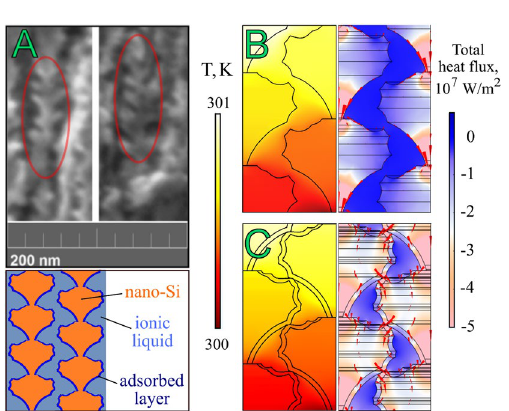
Figure 5. SEM cross-sectional images of PSi (highlighted areas show tentative markers indicating the features of the morphology of the porous structure of silicon) and below a schematic view of averaged by size Si nanocrystalline with a structured IL layer around it as the basis for modelling ( A ); schematic view of temperature distribution on the left half and cross-plane total heat flux q on the right half in PSi ( B ) and "PSi/IL ([BMIm][TFSI])" composite system ( C ), respectively. Red arrows show the directions of heat